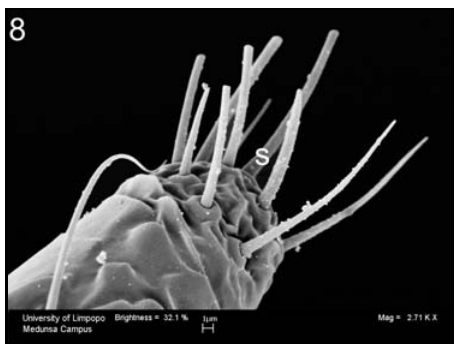
Fig. 8. The distal tip of the antennae constituted 10 apical setae (s).